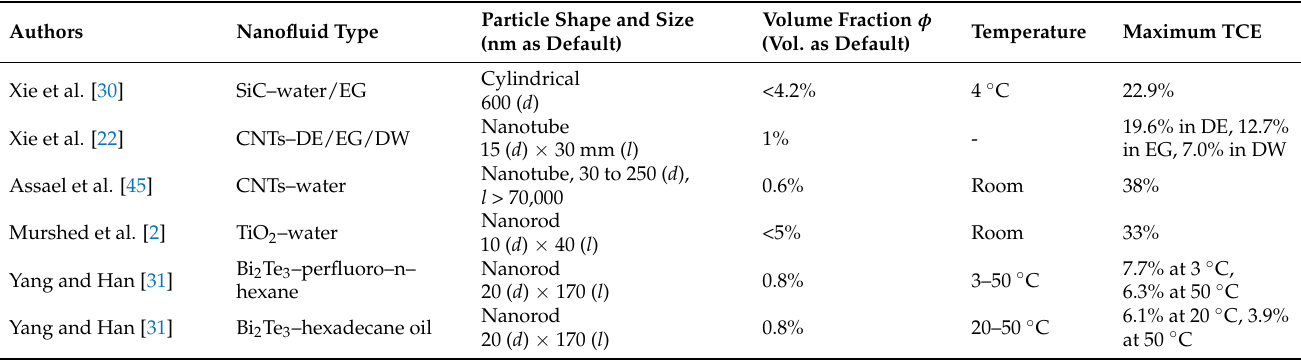
Table 1. Summary of experiments data for heat conductivity of NSN